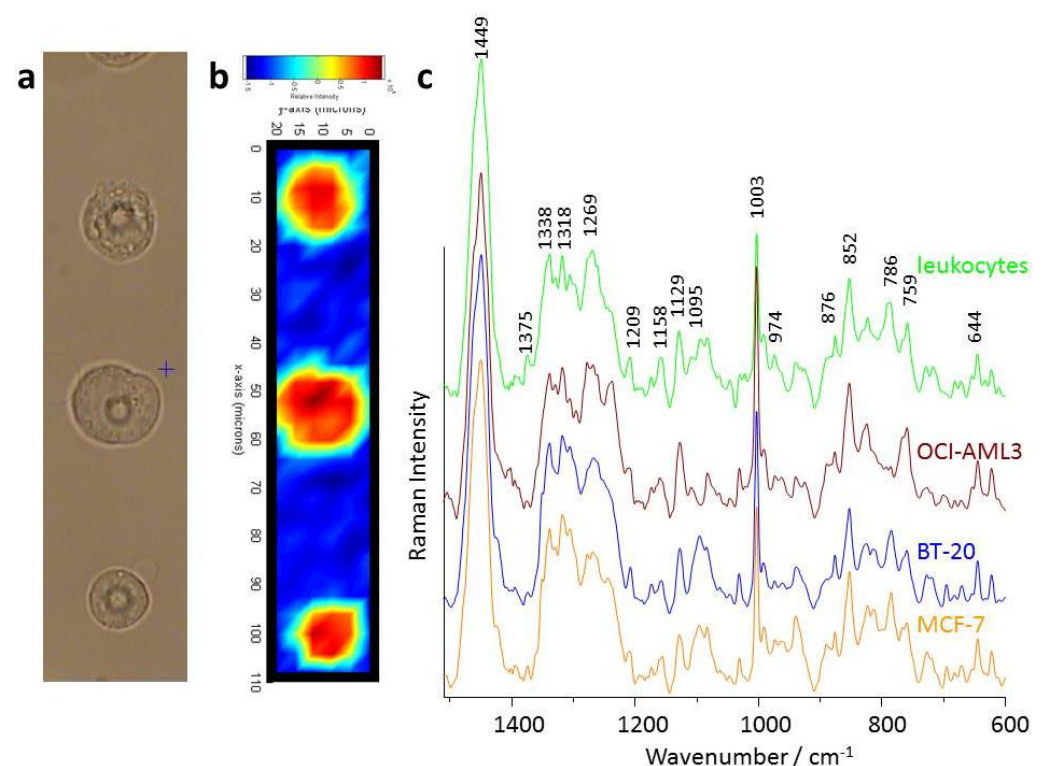
Figure 3. ( a ) MCF-7 captured on the holes; and ( b ) corresponding false color Raman map highlighting the intensity distribution of the CH stretching band around 2940 cm −1 ; ( c ) averaged Raman spectra of the different cell types investigated on the chip.